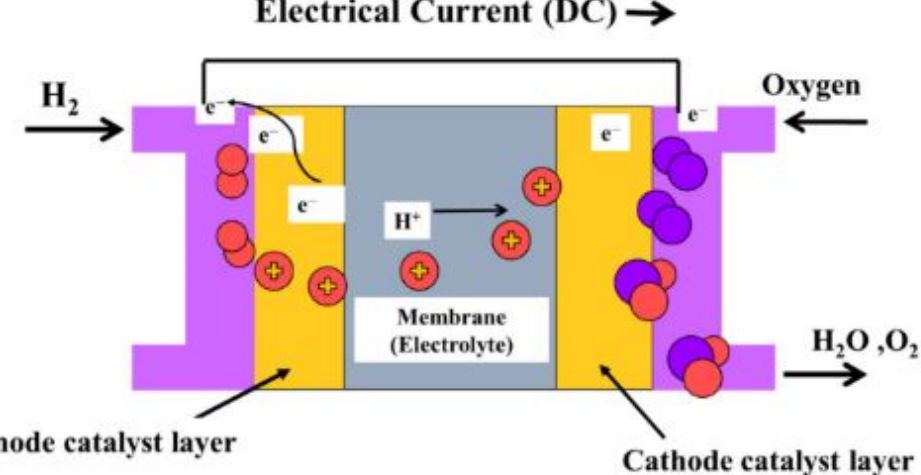
Figure 4. Schematic representation of proton exchange membrane fuel cells [33]. Reproduced with permission from Alashkar et al. (2022), © MDPI, 2022 (Open access—Creative commons attribution 4.0).